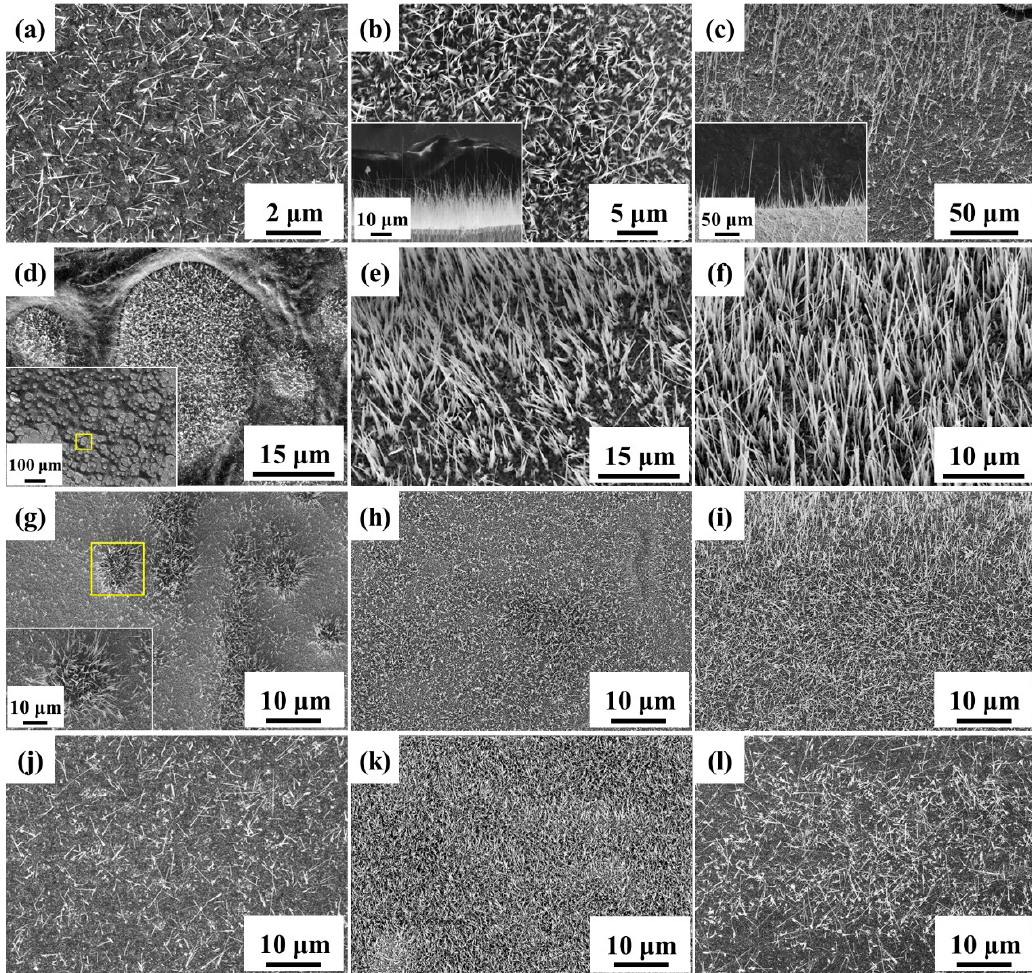
Figure 1. FE-SEM images of CuO nanowires grown at different temperatures ( a ) 350 ◦ C, ( b ) 550 ◦ C, ( c ) 800 ◦ C, for different oxidation time ( d ) 0 h, ( e ) 1 h, ( f ) 2 h, with different ramping rates ( g ) extremely Materials 2019 , 12 , x FOR PEER REVIEW fast, ( h ) 8 ◦ C/min, ( i ) 4 ◦ C/min, and under different oxygen concentrations ( j ) 10%, ( k ) 50%, ( l ) 100%.